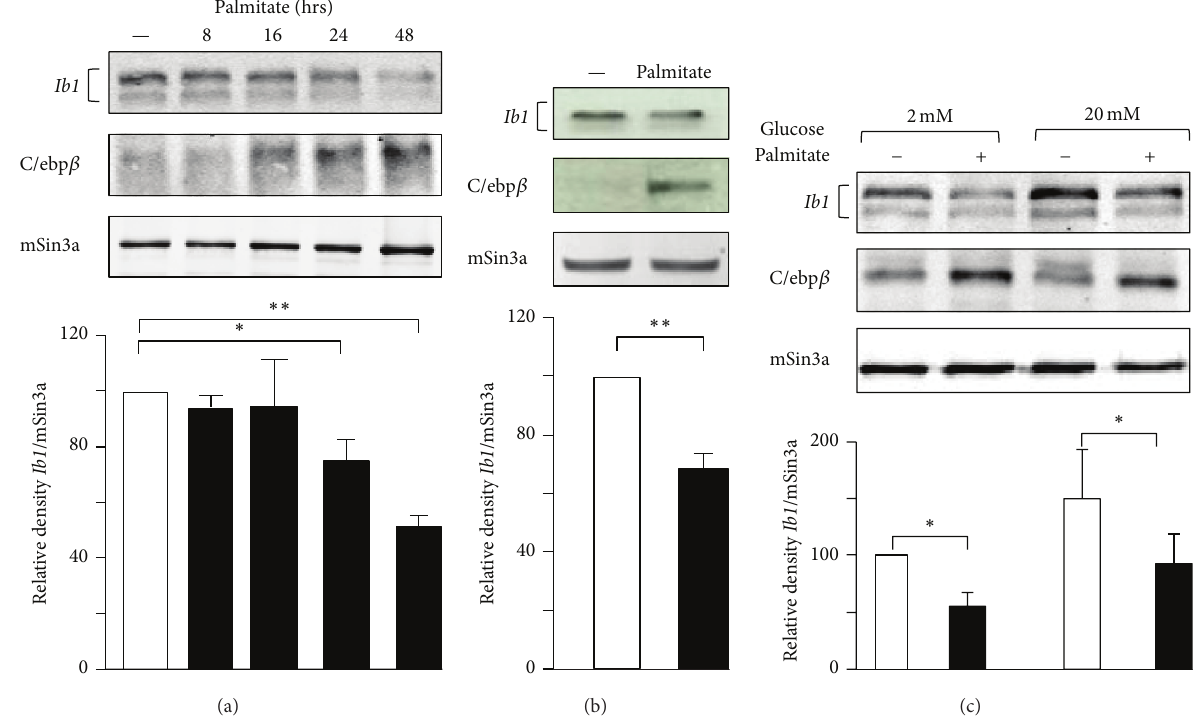
Figure 2: Effect of palmitate on the Ib1 protein level. Total protein was prepared from (a) MIN6 cells or (b) isolated rat islets that were cultured with 0.5 mM palmitate or BSA ( − ) at different indicated incubation times and for 24 hrs, respectively or (b) incubated with BSA or palmitate and (c) INS-1E exposed to BSA ( − ) or 0.5 mM palmitate in the presence of 2mM or 20 mM glucose. As a positive control for the palmitate efficacy, the expression of C/ebp 𝛽 was monitored. Immunoblotting of mSin3a was done as negative control. The Graphs below the blots depict the densitometric analysis. The sum of the Ib1 band intensities of cells treated with BSA was set at 100%. The figure shows the results of a representative experiment out of five. Data are the mean of ± SEM of 3 independent experiments ( ∗∗ 𝑃 < 0.01 ; ∗ 𝑃 < 0.05